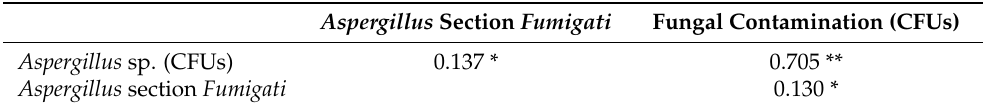
Table 8. Relationship between fungal contamination, Aspergillus sp. and Aspergillus section Fumigati . Spearman’s correlation coefficient.